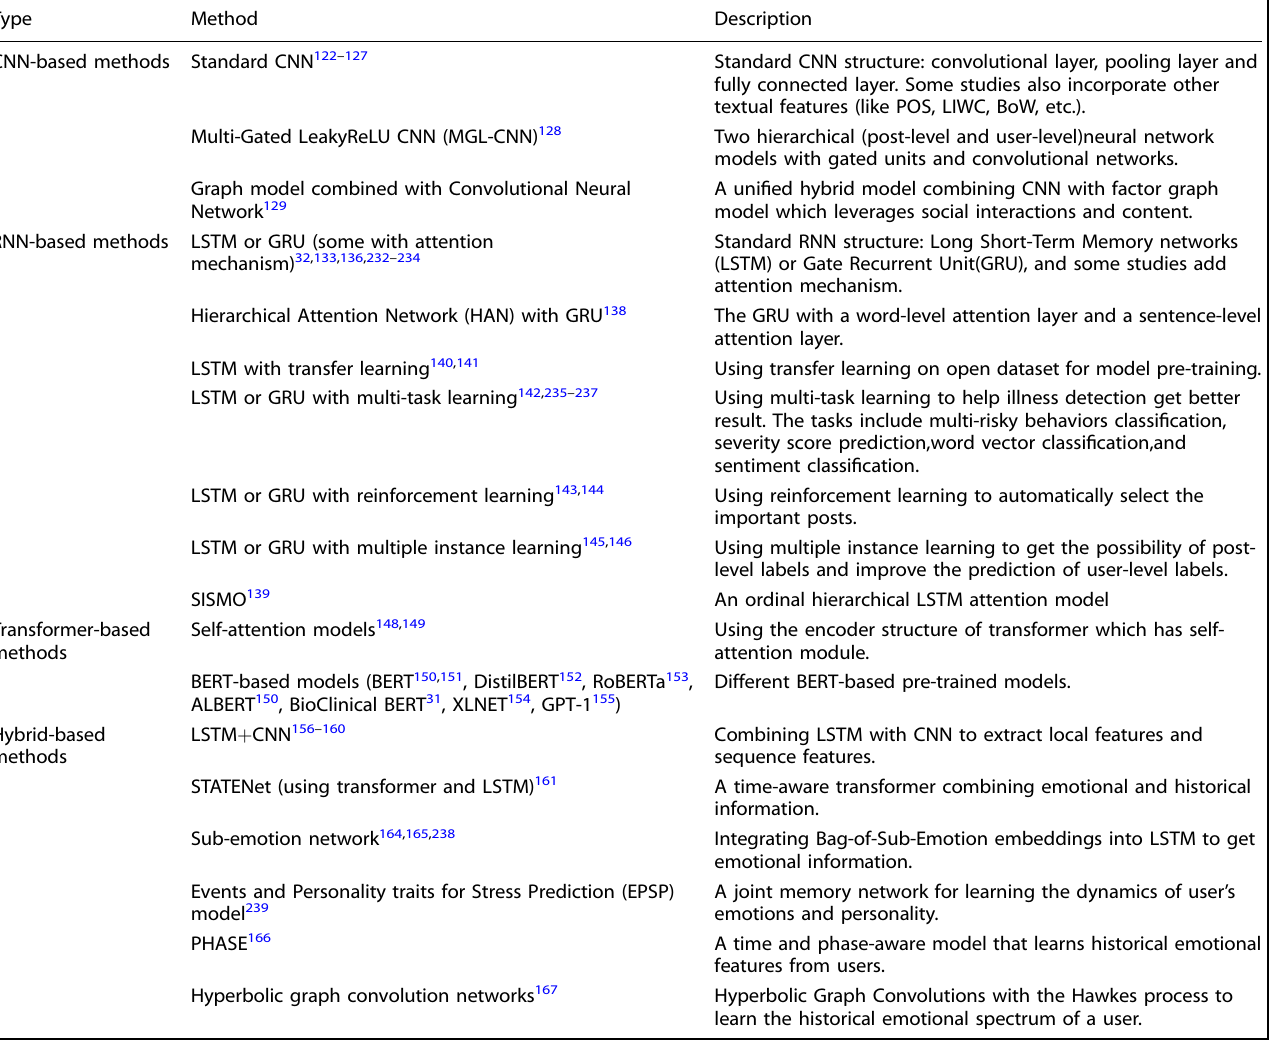
Table 3. The deep learning methods for mental illness